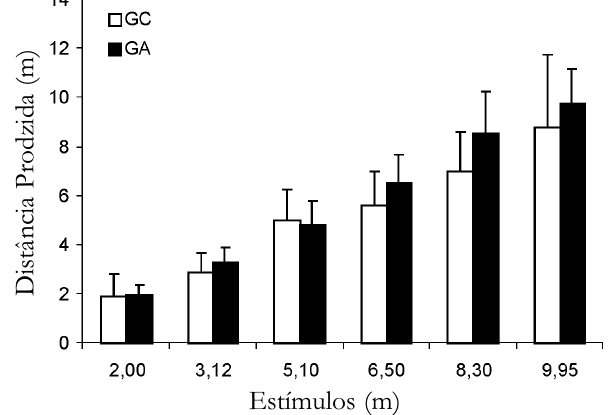
Figura 3. MØdia e desvio-padrªo dos valores da dist(cid:226)ncia produzida para os participantes do grupo crian(cid:231)a (GC) e grupo adulto (GA). As colunas brancas representam o GC, enquanto que as colunas pretas